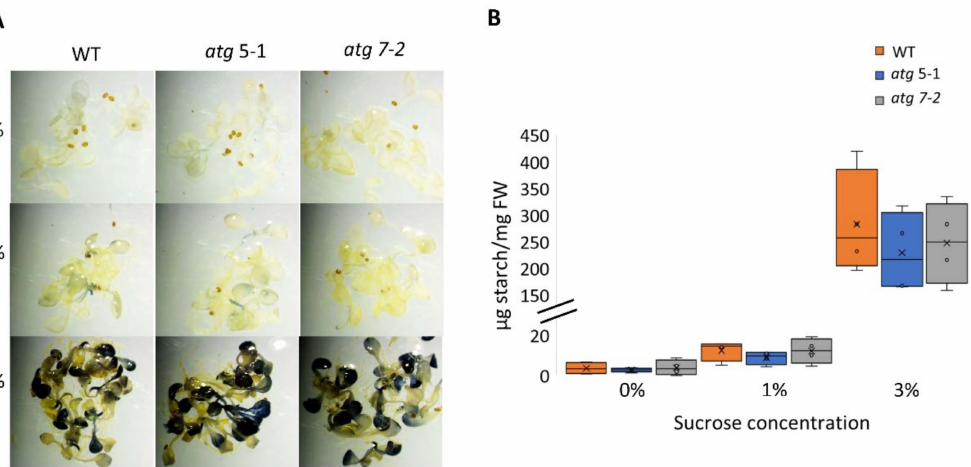
Figure 4. No difference in starch accumulation between WT and atg mutants under sucrose excess. WT, atg5-1 , and atg7-2 plants were sown on Nitsch plates containing increasing concentrations of sucrose and grown for 14 days. ( A ) Representative images of IKI staining of starch. ( B ) Quantification of starch. No significant difference from WT under the same treatment was found by Dunnett’s test ( p < 0.05, n = 4), x indicates sample mean, and circles denote